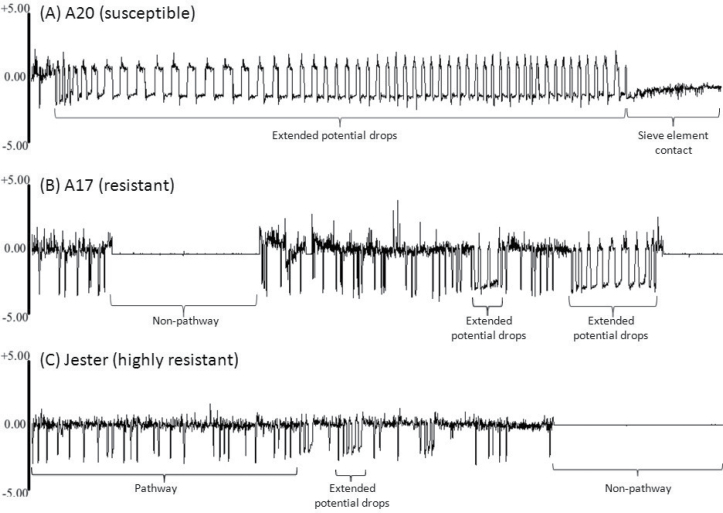
(A–C) EPG showing representative waveform patterns produced when SAA apterae feed on the susceptible accession A20 (A), moderately resistant accession A17 (B), or highly resistant accession Jester (C). The horizontal axes represent a 1h time period; the vertical axes represent voltage. Histological studies of plant–aphid interactions have correlated stylet positions in plant tissues with specific EPG waveforms (Tjallingii, 1988). ‘Non-pathway’ indicates stylets are outside the plant, while ‘pathway’ indicates mostly intramural probing activities between mesophyll or parenchyma cells. ‘Sieve element contact’, consisting primarily of sap ingestion with short periods of salivation into sieve elements, was frequently seen with plants of A20 and significantly less on plants of A17 and only rarely seen with plants of Jester. Sharp, downward spikes, named potential drops, indicate cell puncture events by stylets, each lasting approximately 5 s. A novel waveform that we termed extended potential drops were sharp downward spikes that lasted more than 5 s. (D) Percentage of time SAA apterae spent in various activities on A20, A17 and Jester during 9h exposure to the host plants. (E) Detailed analysis of the two different types of potential drops in the three M. truncatula lines. Each value represents the mean±SEM of 12–14 biological replicates. Means for the accession not connected by the same letter are significantly different (P<0.01).